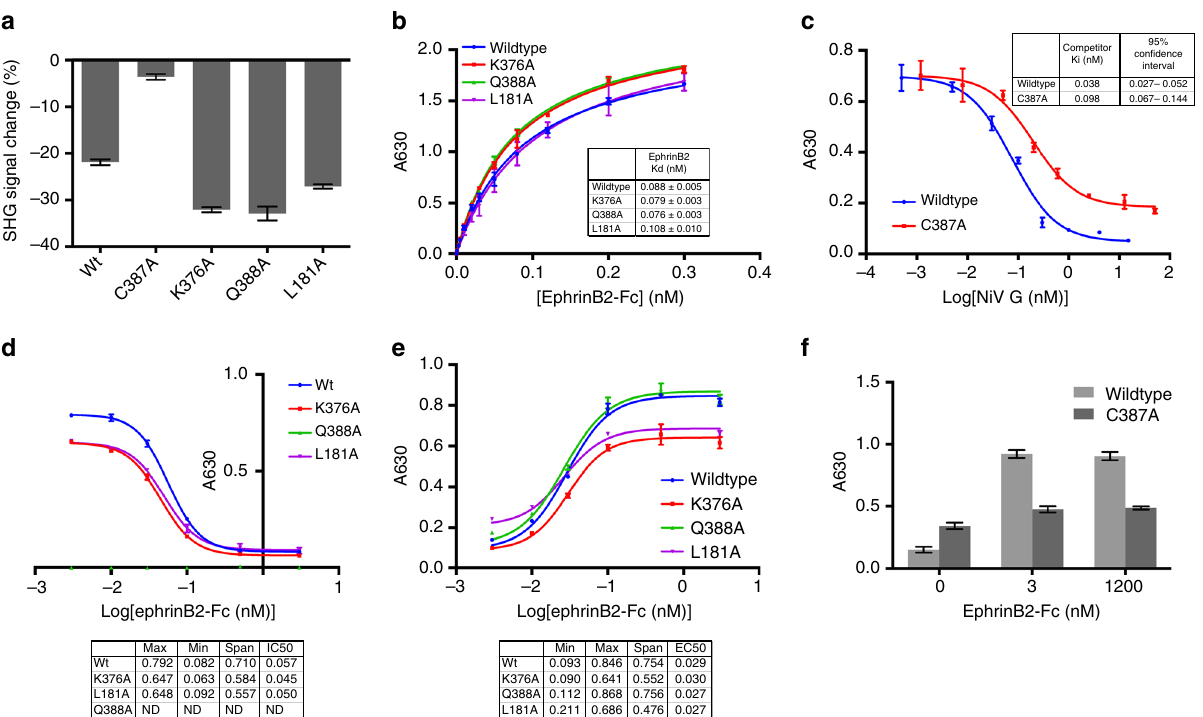
Fig. 2 Response of NiV G mutants to ephrinB2-Fc binding measured by SHG and conformational antibody binding. a Change in SHG signal of NiVG ectodomain constructs bound at 0.5 μ M at 20 min following ephrinB2-Fc addition to 0.6 μ M. b Binding af fi nity of ephrinB2-Fc to NiV G ectodomain constructs measured by direct ELISA. c Inhibition of wildtype NiV G binding to ephrinB2-Fc by wildtype NiV G and a C387A mutant. d Binding of mAb213 to NiV G constructs with increasing ephrinB2-Fc concentration. e Binding of mAb45 to NiV G constructs with increasing ephrinB2-Fc concentration. f Binding of mAb45 to wildtype NiV G and a C387A mutant with increasing ephrinB2-Fc concentration. Mean and s.d. values for SHG data are shown from a representative experiment, n = 3. Mean and s.d. values for ELISA data are shown from a representative experiment, n =